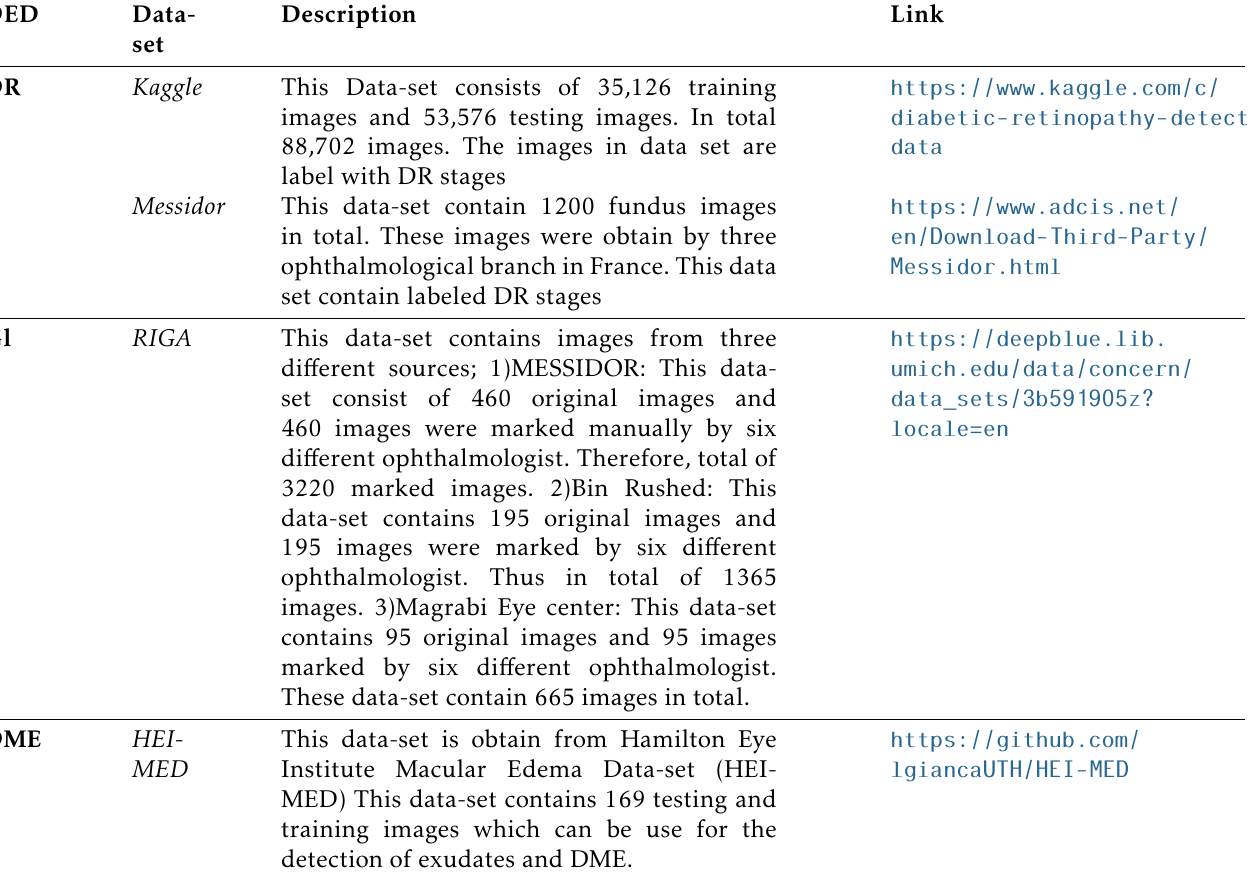
Table 1. Available Data-set and their